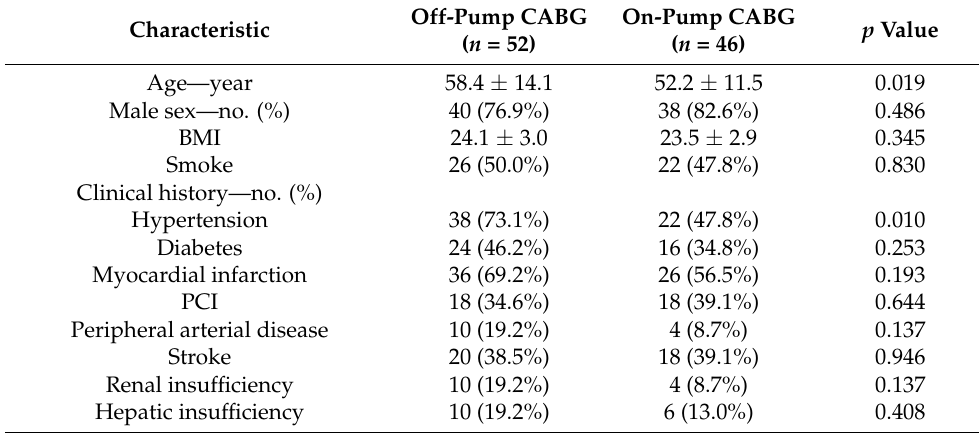
Table 1. Baseline characteristics of the patients before